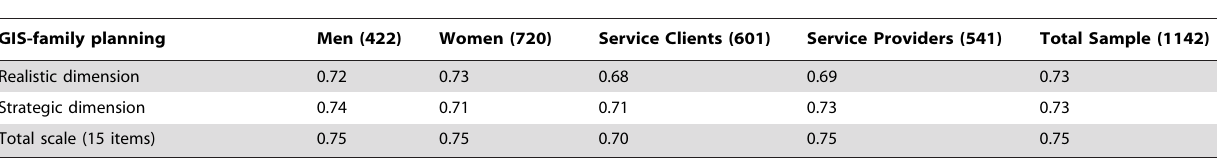
Table 3. Alpha Internal Consistency Coefficients for 15-item GIS-family planning.